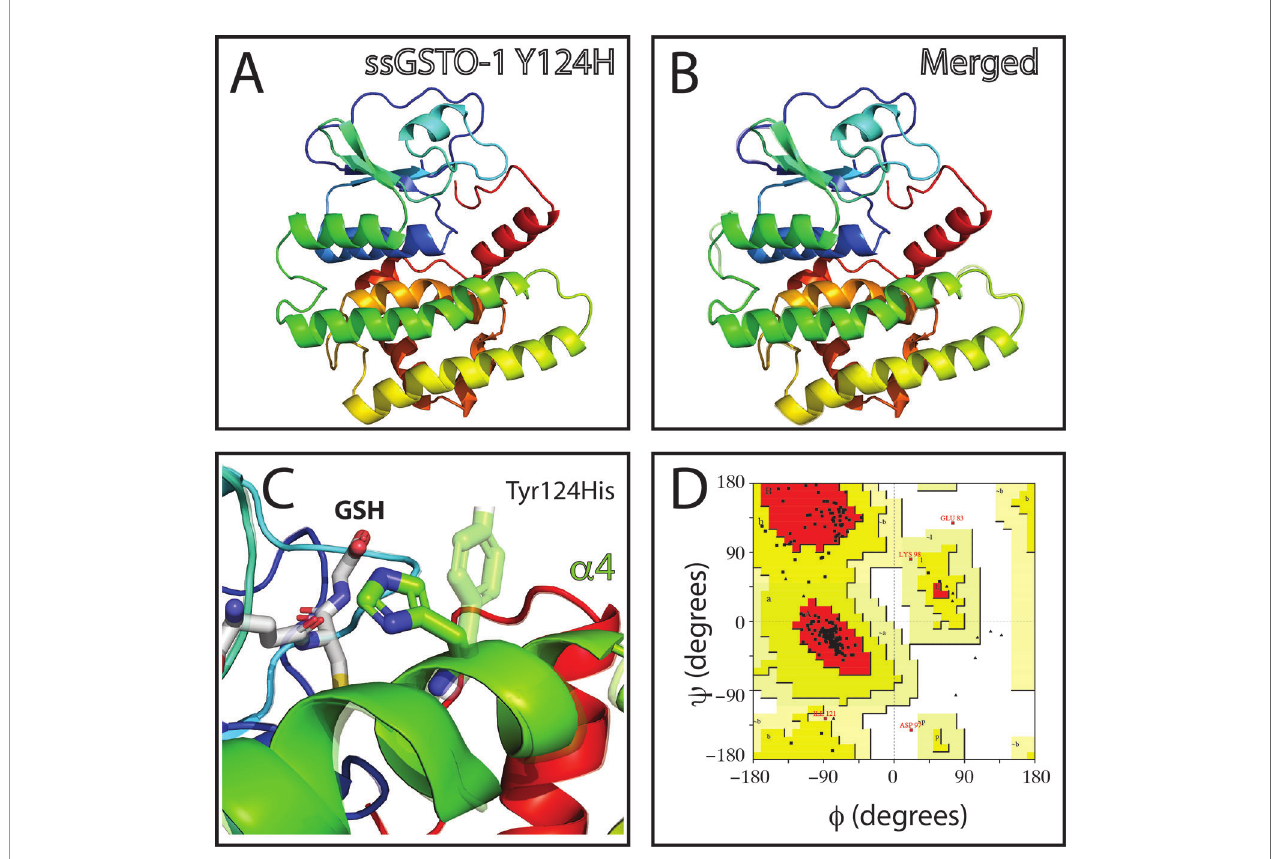
FIGURE 4 | Evaluation of single-nucleotide polymorphism (SNP) c.499T > C effect on the predicted S. salar GSTO-1 (sGSTO-1) structure by homology modeling. (A) Predicted tridimensional sGSTO-1 including the Y124H substitution (sGSTO-1 Y124H). (B) sGSTO-1 and sGSTO-1 Y124H overlay. The punctual amino acid substitution (dotted arrow line) is indicated. (C) Enlarged view of the sGSTO-1 Y124H substitution shown in (B) . sGSTO-1 (transparent), sGSTO-1 (colored), and the reduced glutathione (GSH) molecule are shown. (D) Ramachandran plot for the predicted sGSTO-1 Y124H structure. The amino acid distribution into most favored regions (A,B,L), additional allowed regions (a,b,l,p), generously allowed regions (~a,~b,~l,~p), and disallowed regions (GLU83, ASP97) is